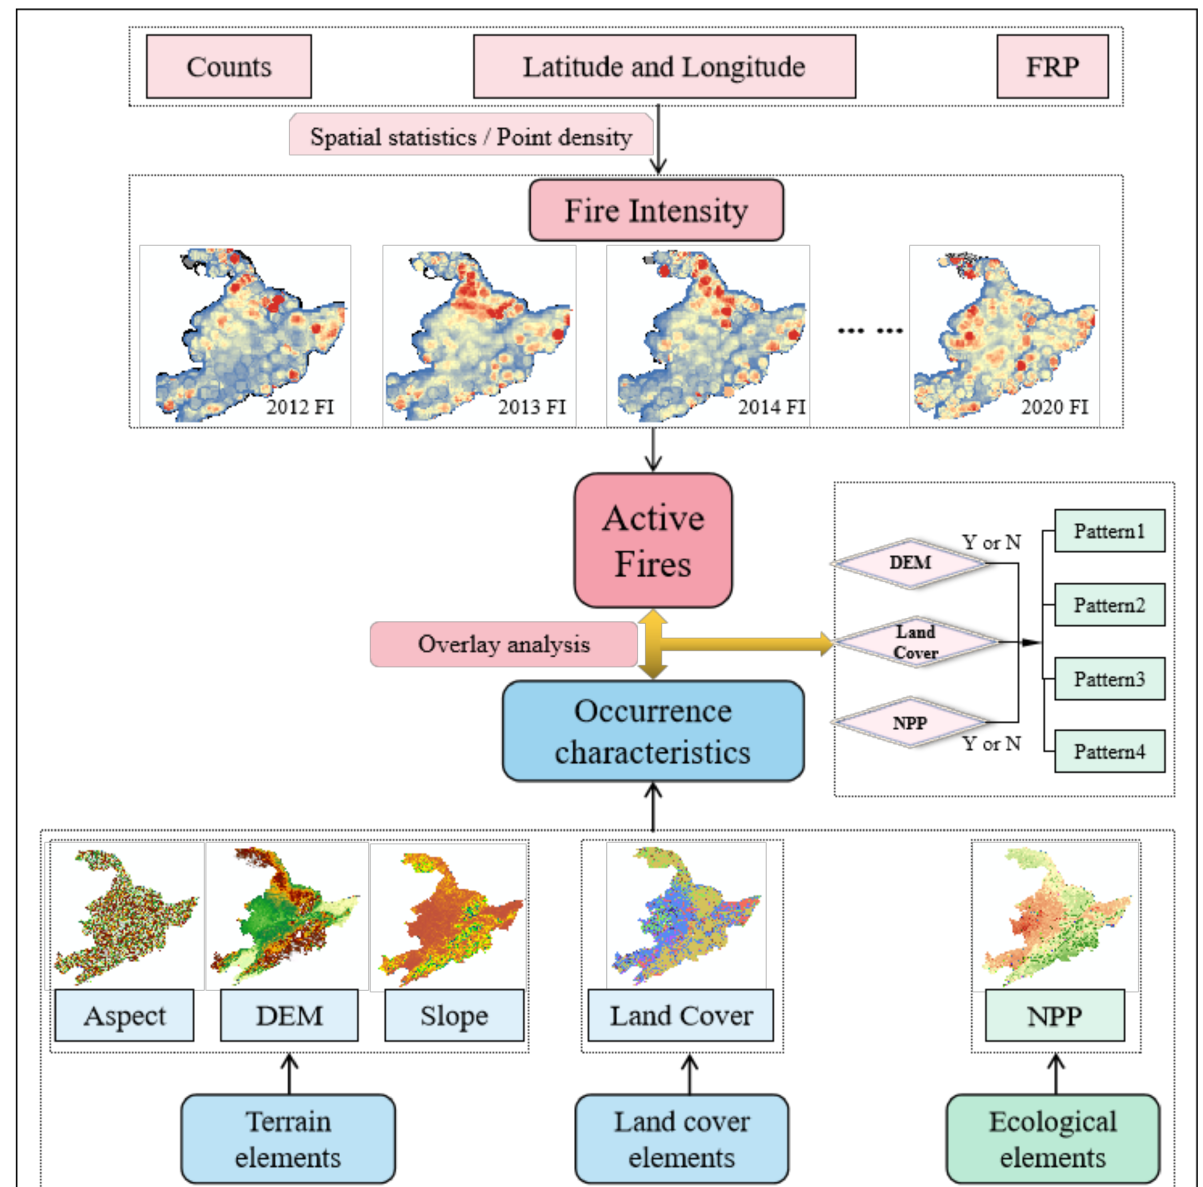
Figure 2. The workflow for delineating fire-hazardous areas and fire-induced patterns based on Visible Infrared Imaging Radiometer Suite (VIIRS) active fires in Northeast